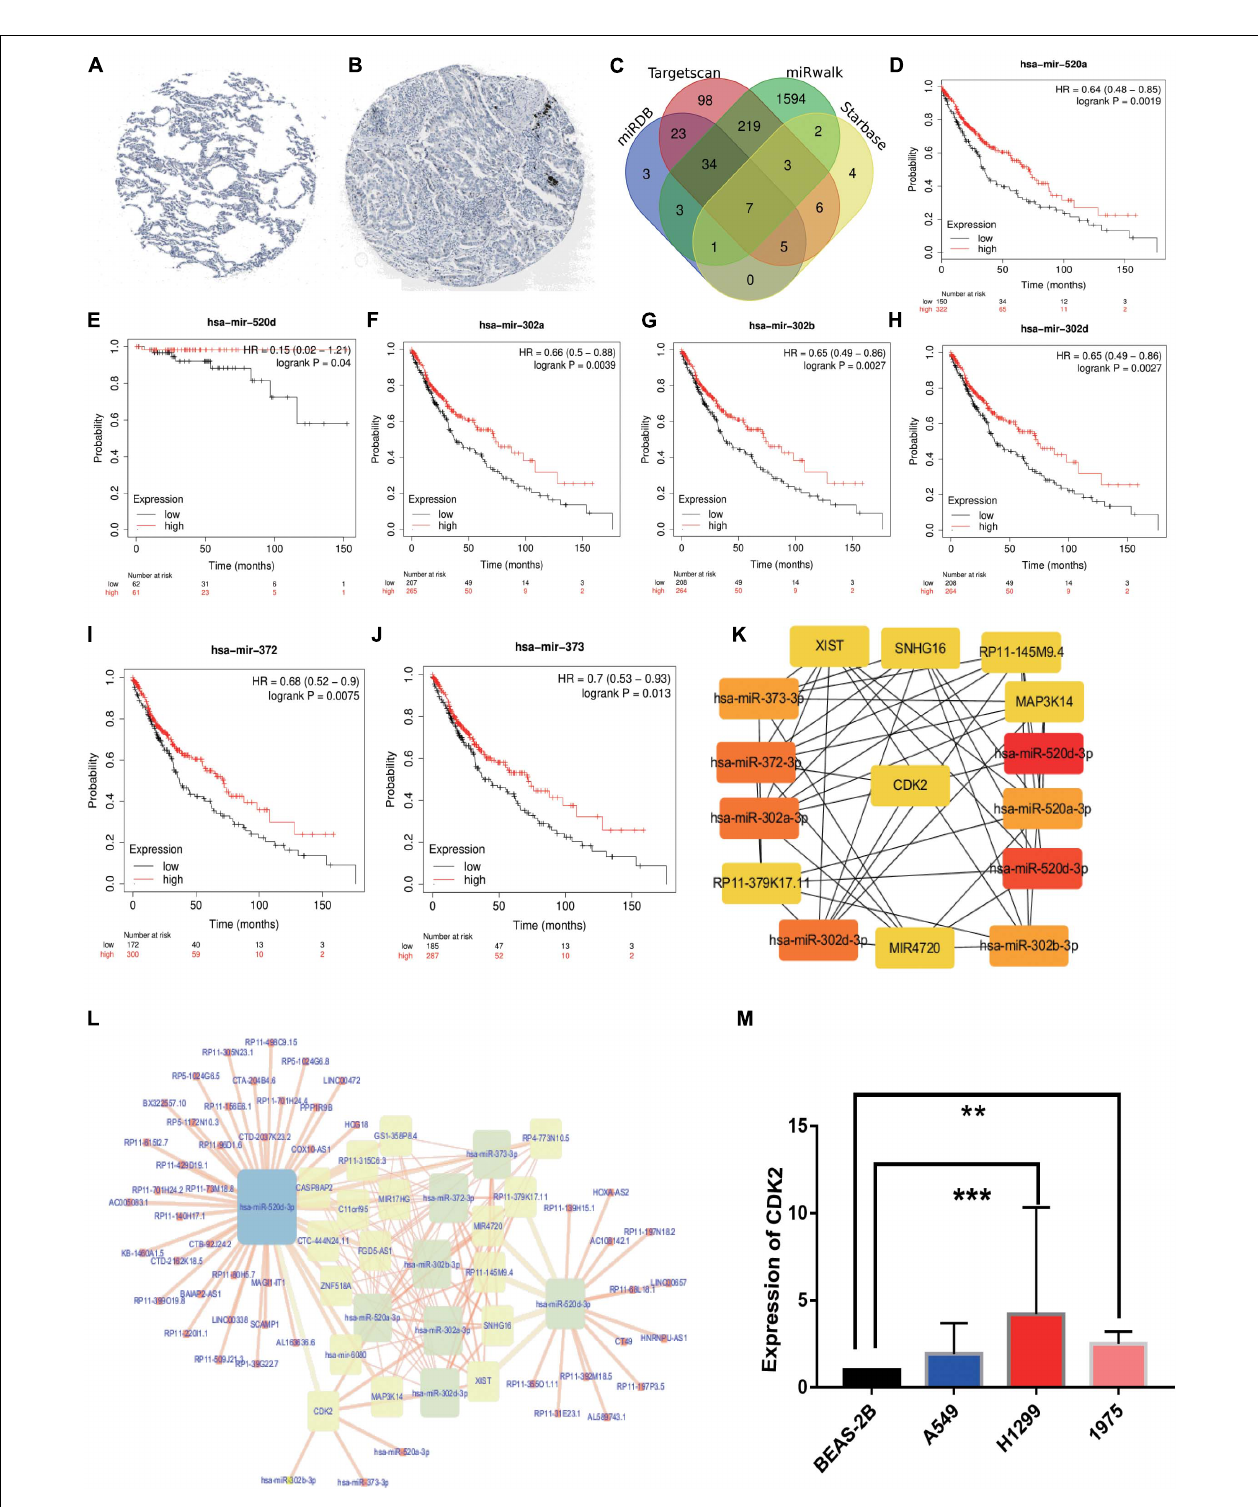
FIGURE 11 | HPA analysis and ceRNA network. (A) Immunohistochemical results in normal lung tissues. (B) Immunohistochemical results in LUAD tissues. (C) The intersection results of the four databases were shown by Venn diagram. (D–J) The survival analysis of seven miRNAs. (K) 6lncRNAs-7miRNAs-CDK2 were considered as top 15 genes by CytoHubba . (L) ceRNA network was constructed by Cytoscape. (M) The PCR results about CDK2 expression in BEAS-2B, A549 ( P = 0.0808), H1299 ( P = 0.0006), H1975 ( P = 0.0030). (** P < 0.01, *** P < 0.001).